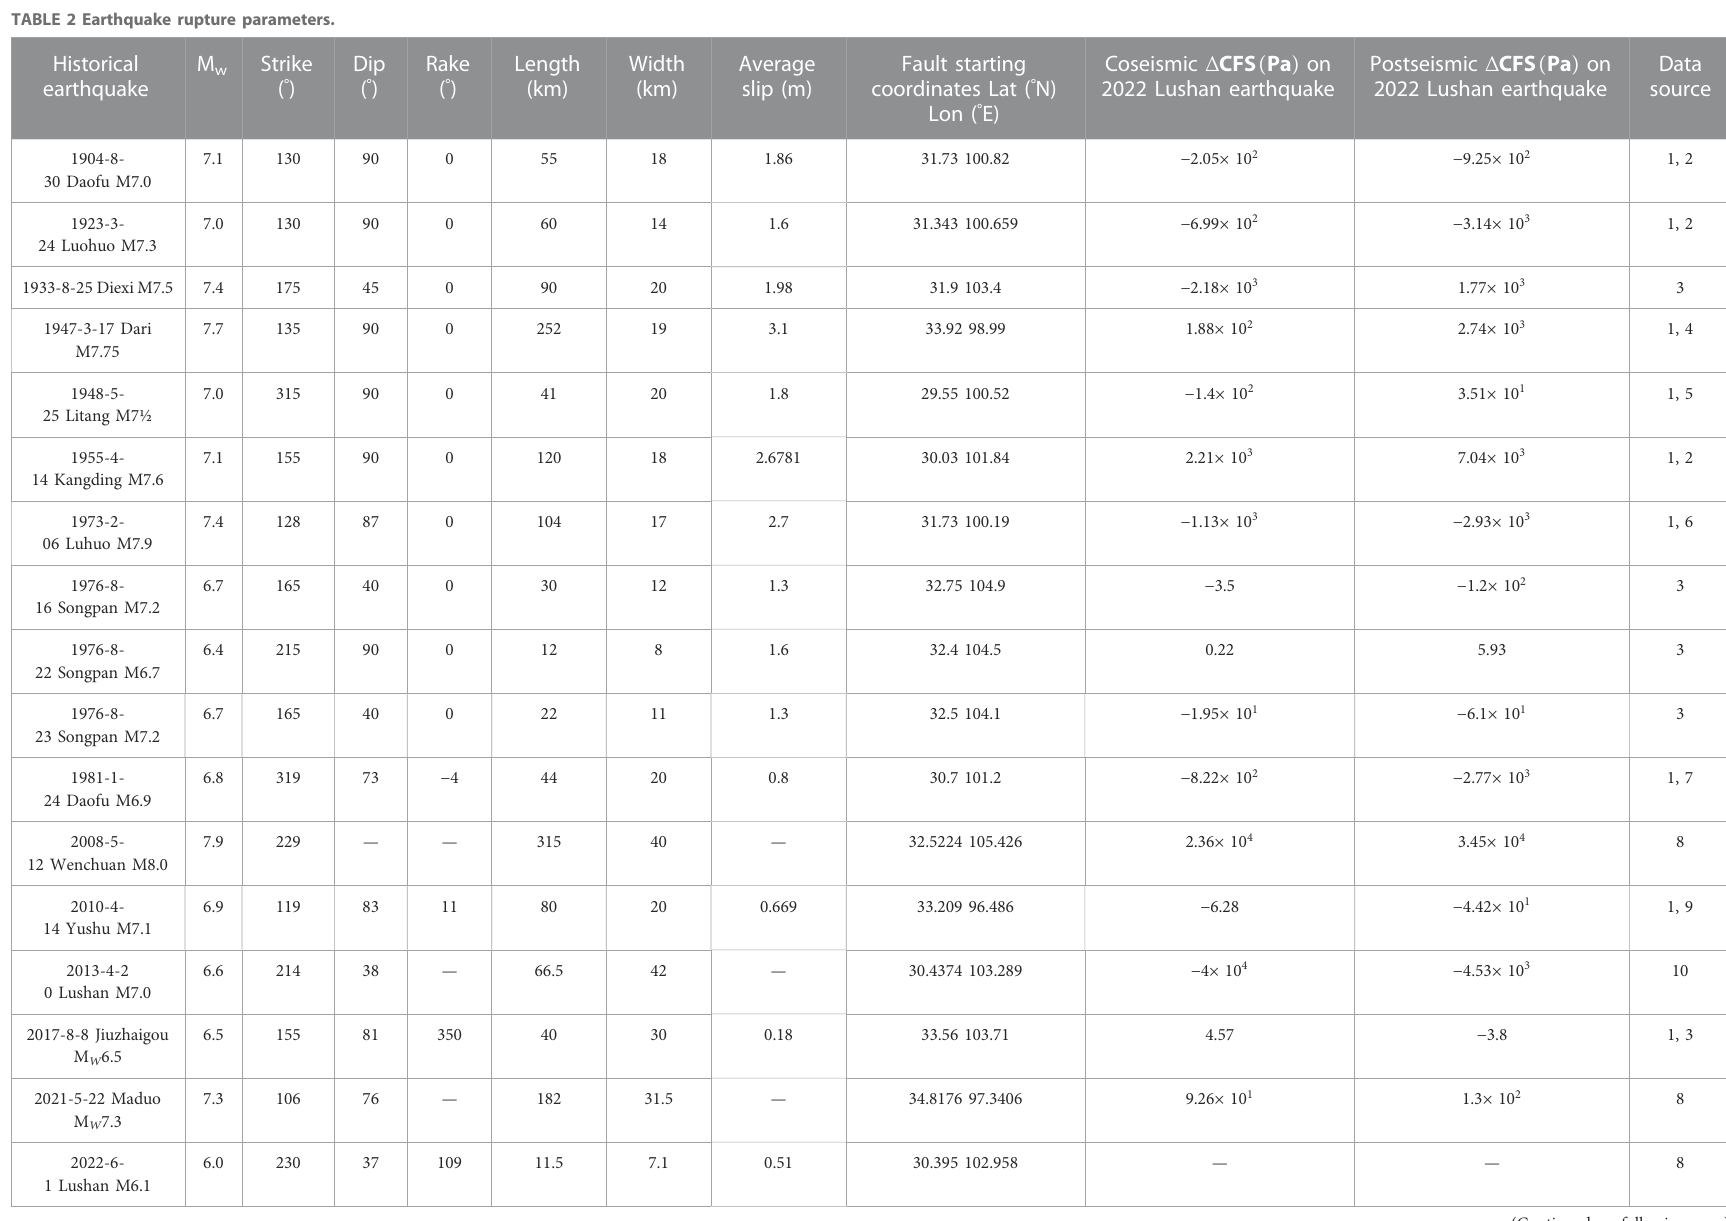
Coseismic Δ CFS ( Pa ) on 2022 Lushan earthquake